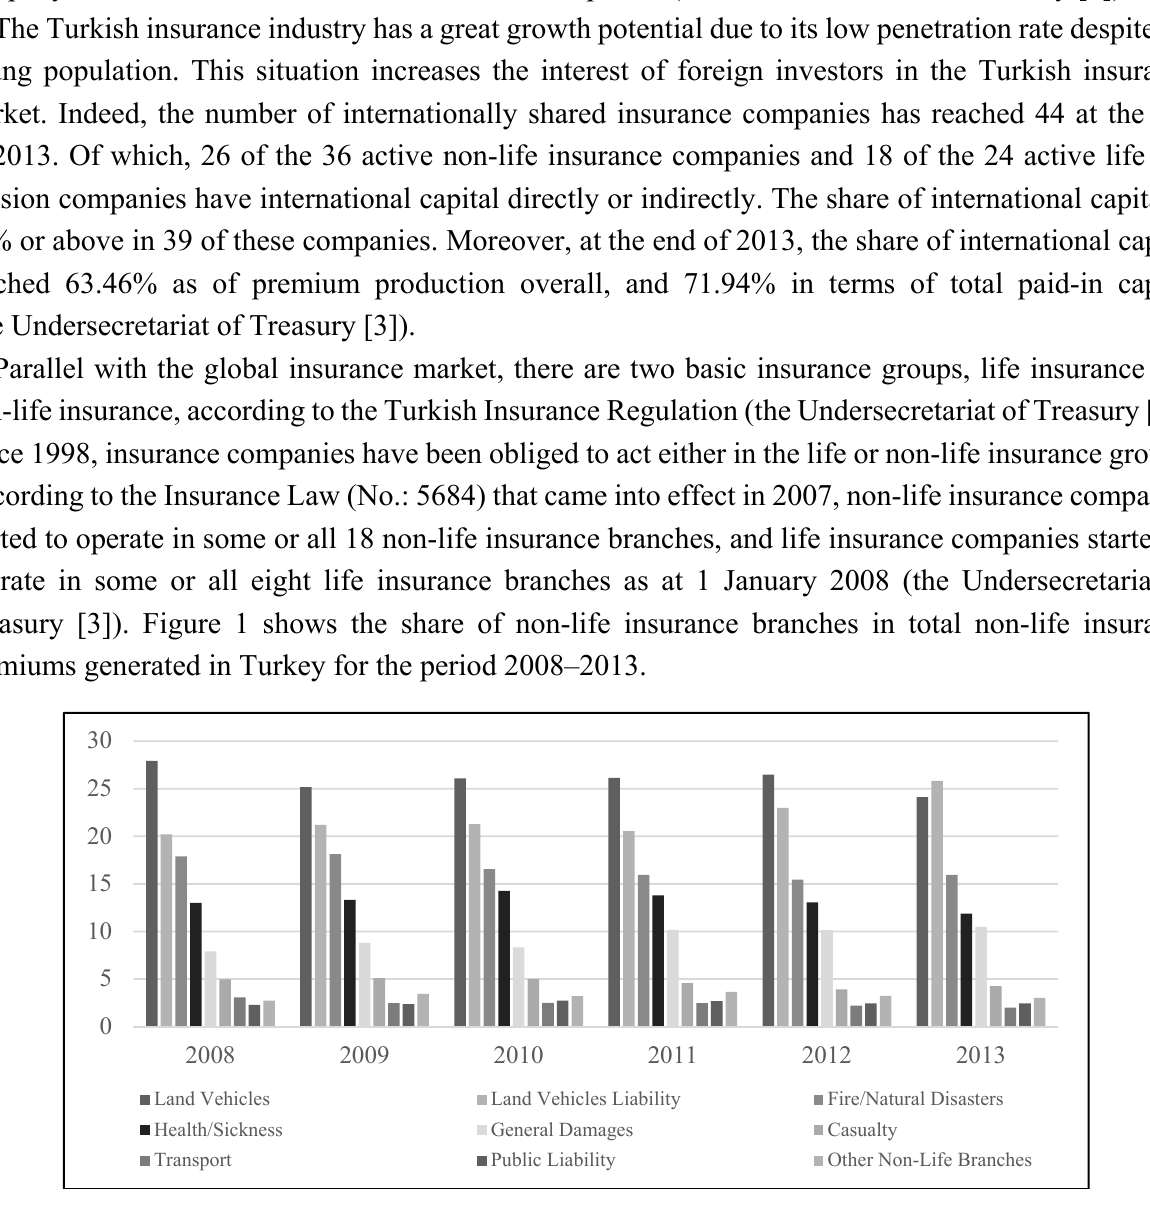
Figure 1. The share of premium for each non-life insurance branch in the Turkish non-life insurance industry (%). Source: own graphic based on the Undersecretariat of Treasury’s Annual Reports about Insurance and Private Pension Activities (the Undersecretariat of Treasury